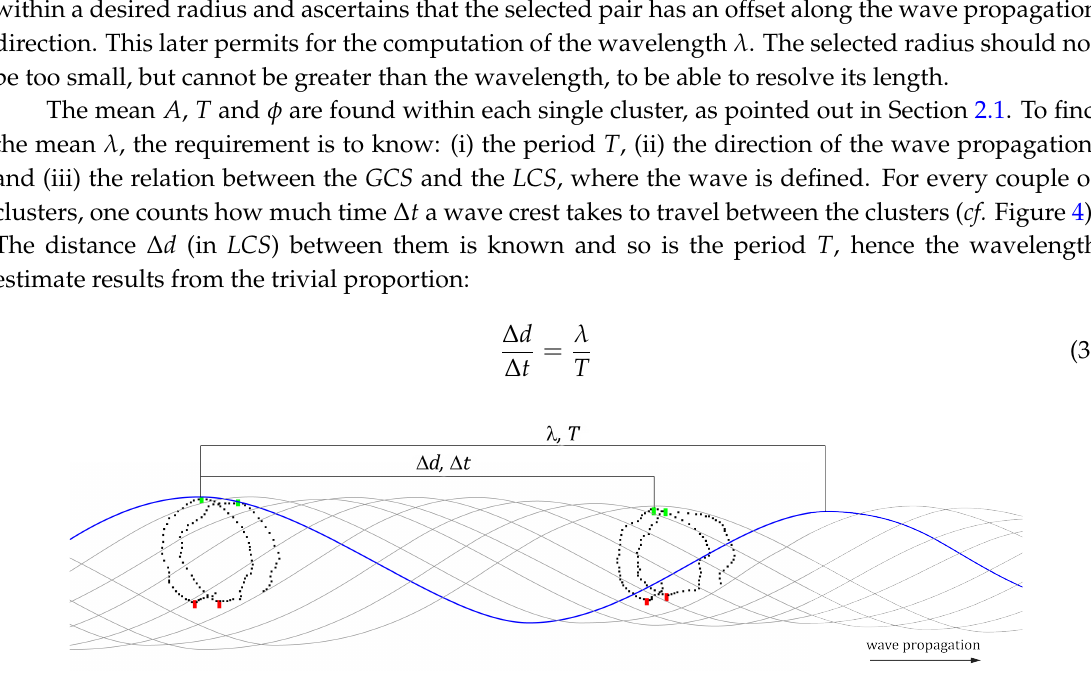
Figure 4. Image-based approximate wave retrieval. For this cluster pair, the wave crest takes eight frames ( ∆ t ) to travel between the neighbors. If the distance between the clusters is ∆ y = 10 cm and the period T = 12, then the wavelength λ = 15